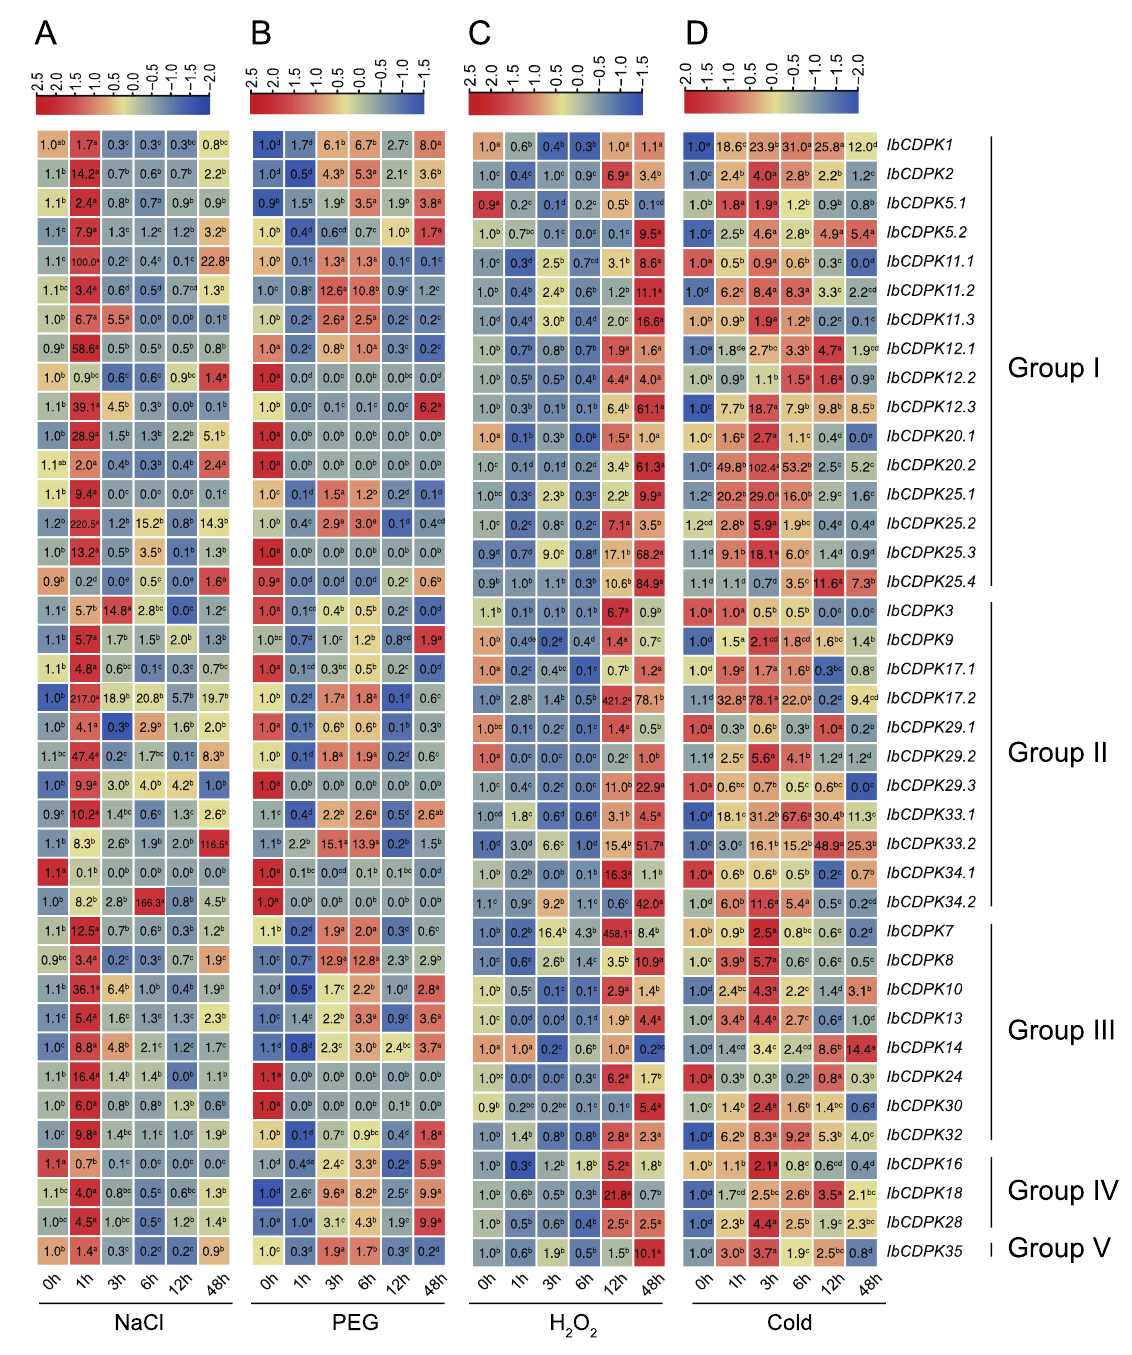
Figure 10. Gene expression patterns of IbCDPKs in response to abiotic stresses, i.e., ( A ) NaCl, ( B ) PEG, ( C ) H 2 O 2 , and ( D ) cold, of I. batatas. The values were determined by RT-qPCR from three biological replicates consisting of pools of three plants, and the results were analyzed using the comparative C T method. The expression of 0 h in each treatment was considered “1”. The fold change is shown in the boxes. Different lowercase letters indicate significant differences ( p < 0.05; Student’s t - test).